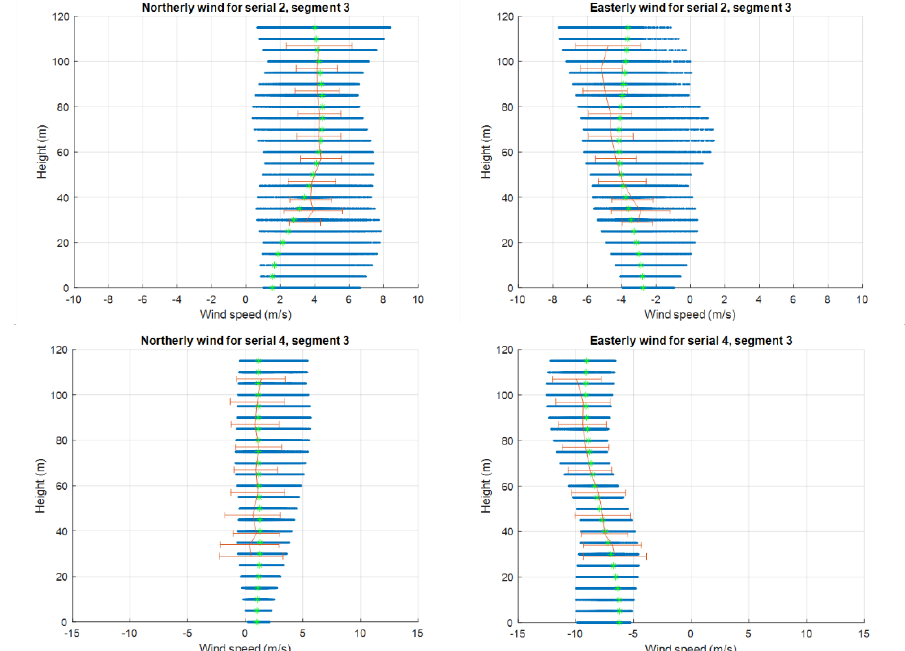
Figure 1: Comparison between horizontal wind speed components observed by LIDAR (red) and UAV-based AAT (green)